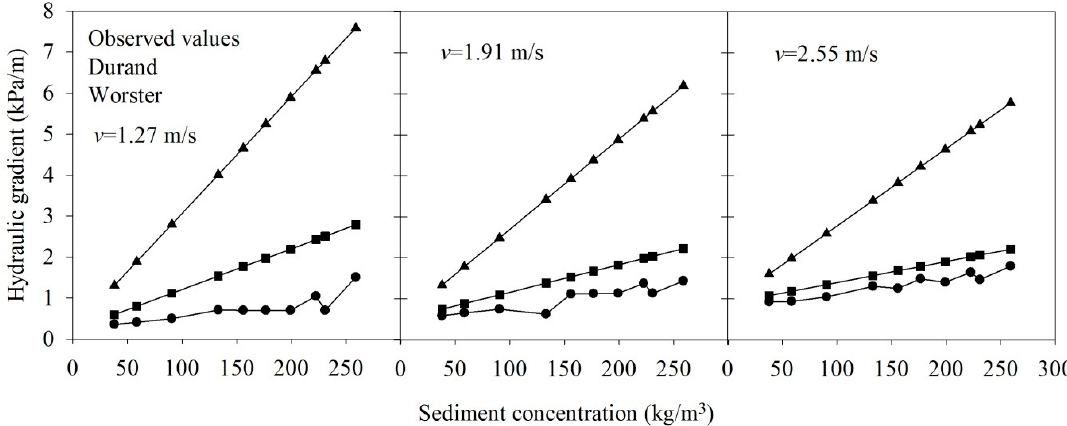
Figure 9. Comparison of the observed and simulated values at different flow velocities (inverse slope = 60°).